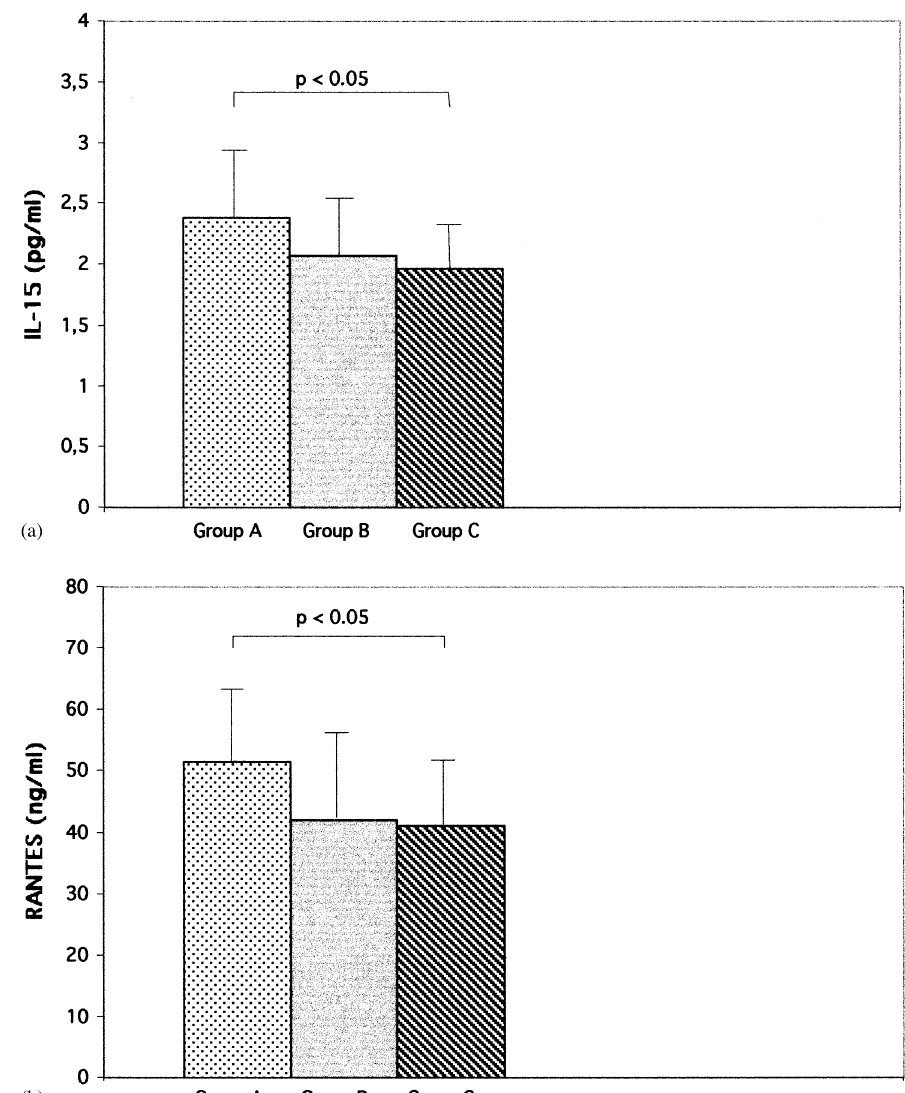
FIG. 1. (A) IL-15 serum levels in patients with Parkinson’s disease treated with levodopa (group A), in untreated PD patients (group B) and in healthy controls (group C). (B) RANTES serum levels in patients with PD treated with levodopa (group A), in untreated PD patients (group B) and in healthy controls (group